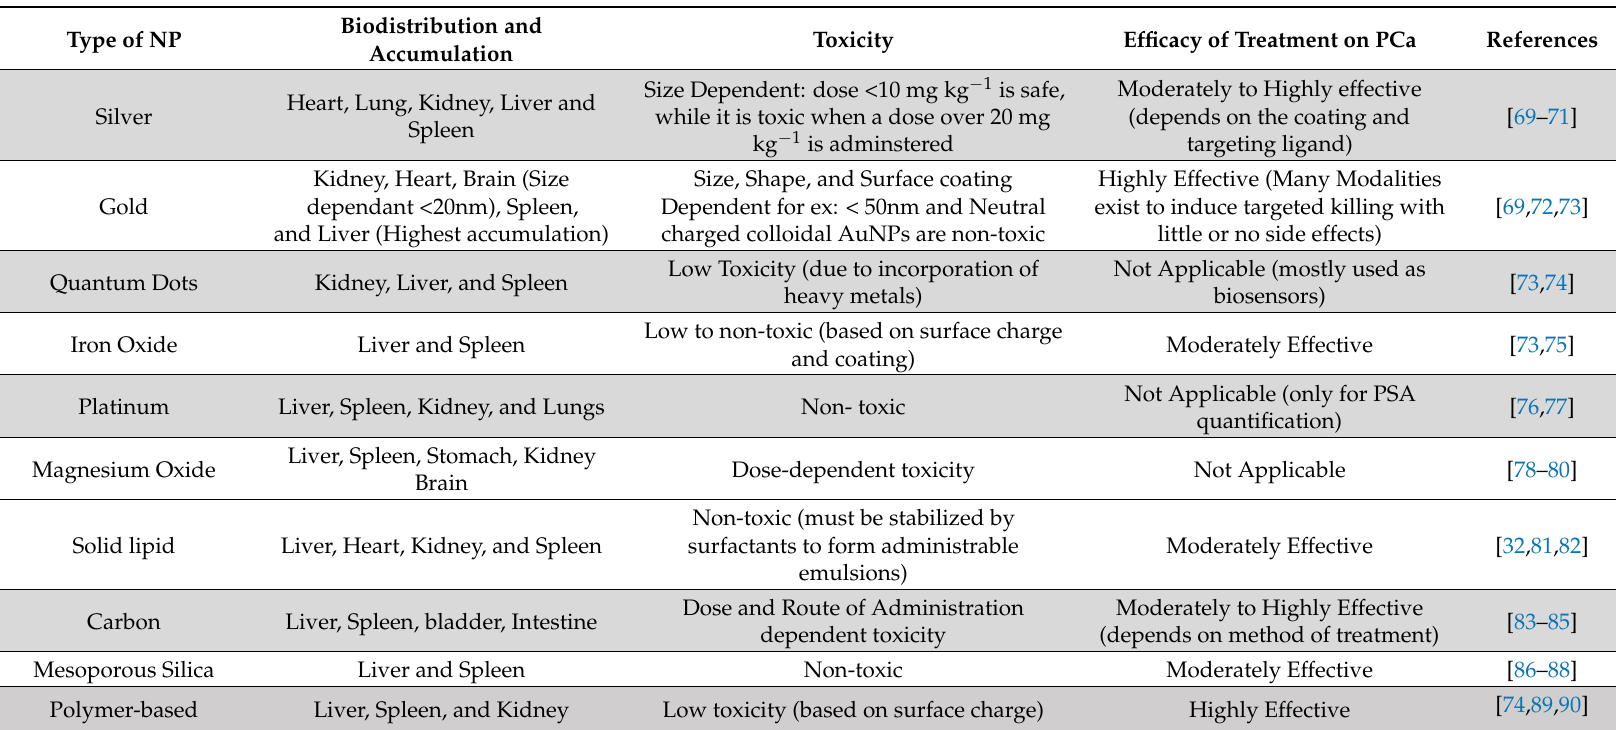
Table 1. A comparative table of the various Gold nanoparticle-based treatments for prostate